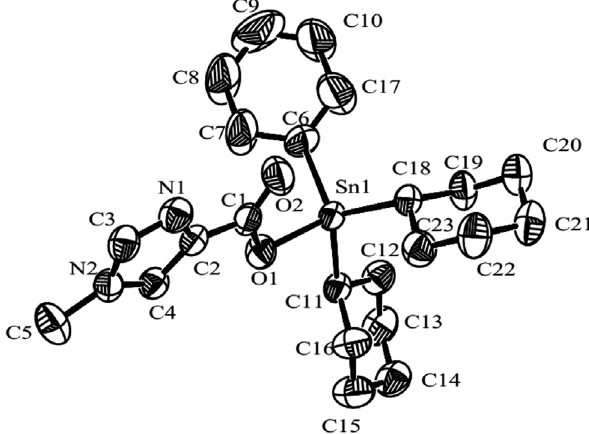
Figure 1: Molecular structure of complex 1 (ellipsoids at 30% prob- ability; hydrogen atoms are omitted for clarity).